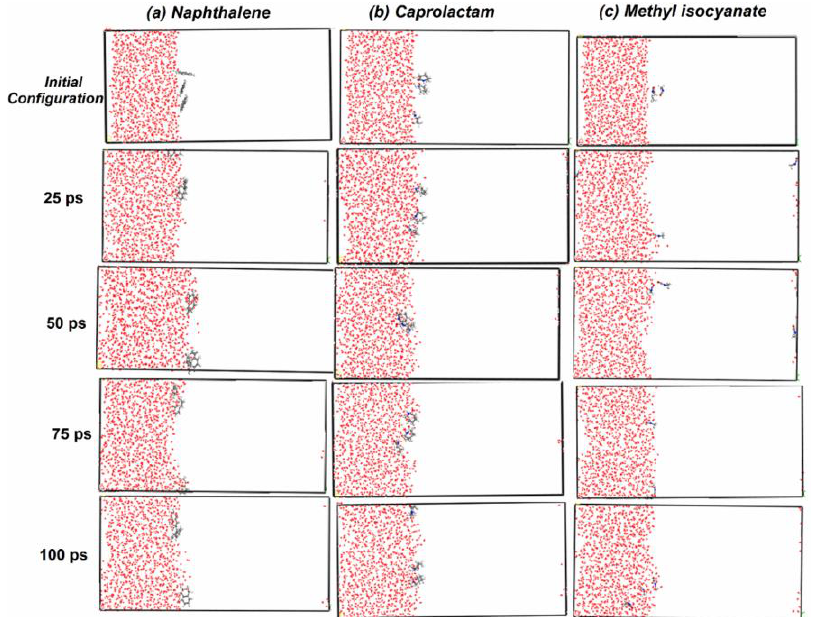
Figure 6. MD simulation depicting the evolution of SVOC dispersion with respect to simulation time: a) NAPH, b) CAP, c) MIC (Red dots represent water molecules and black dots